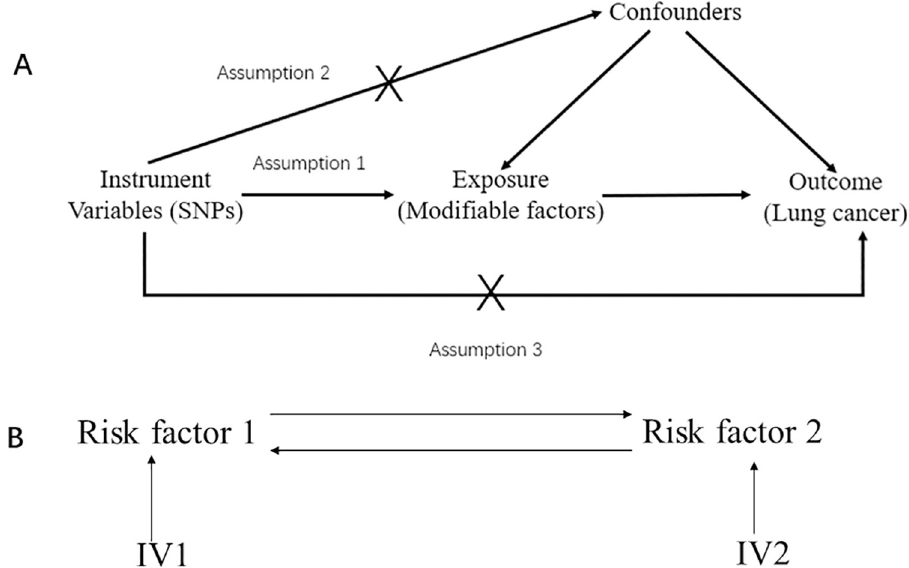
Fig 1. The basic principles underlying Mendelian randomization. Fig 1A is the three assumptions for Mendelian randomization analysis. Fig 1B is the basic principles of bi-directional Mendelian randomization. SNP is the single nucleotide polymorphism and IV is the instrumental